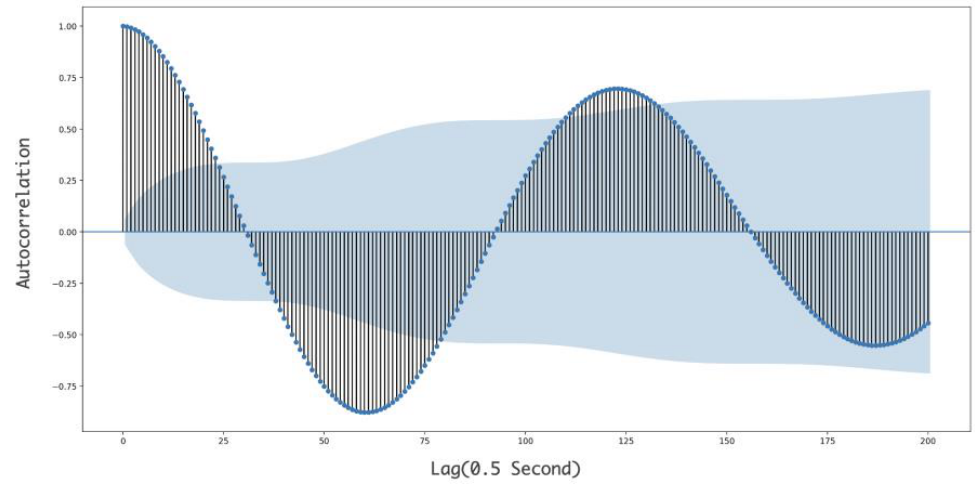
Figure 10. Result of autocorrelation analysis.